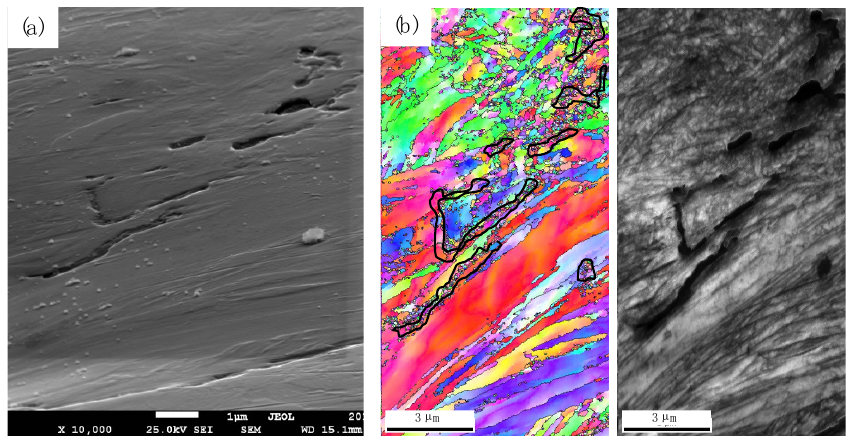
Figure 13. ( a ) Scanning electron micrograph of micro-void formation and coalescence due to the hydrogen-enhanced strain-induced vacancy mechanism (HESIV); ( b ) EBSD analysis of micro-void location at prior austenite and block boundaries within the martensitic microstructure.